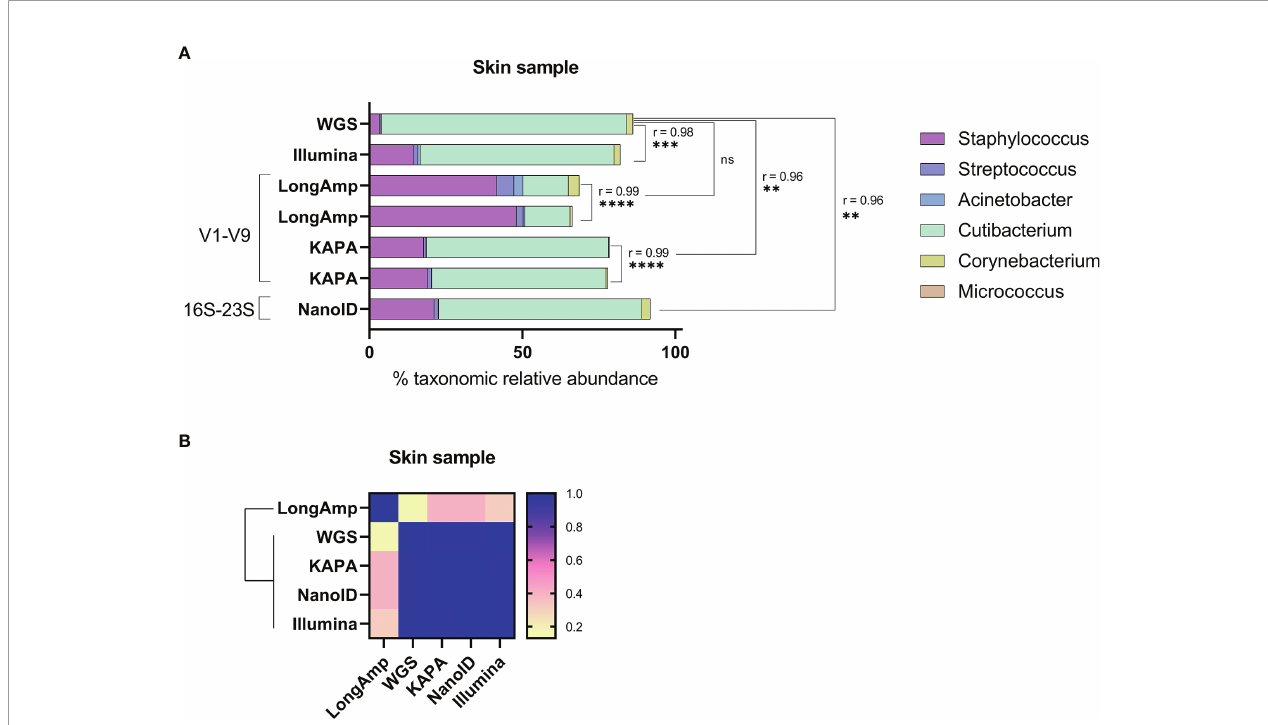
FIGURE 2 | Testing of different ampli fi cation methodologies for MinION ™ sequencing of human skin sample microbial communities. (A) Comparison of taxonomic pro fi les of classi fi ed reads of the skin sample communities. The Pearson coef fi cient (r) between sequencing methods was computed to highlight a signi fi cant correlation between samples and/or methodologies. ns, not signi fi cant; **P ≤ 0.01; ***P ≤ 0.001; ****P ≤ 0.0001. (B) Similarity matrix and hierarchical clustering of the methodologies based on their relative abundance pro fi